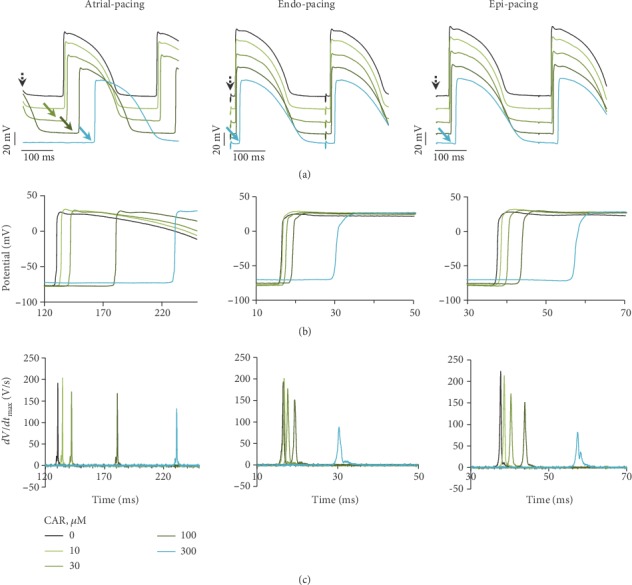
CAR effects on the APs of the Langendorff-perfused rabbit hearts. (a) Representative traces of APs from microelectrodes obtained with atrial, endocardial, and epicardial pacing under control conditions (i.e., Tyrode solution; black) and at 10, 30, 100, and 300 μM cumulatively increased concentrations of CAR (light green, green, dark green and light blue, respectively). Insert: CAR concentrations as indicated in μM. The broken black arrow indicates the start of the stimulus. Solid arrows denote the rightward shift in the AP activation time. (b) Superimposition of AP upstrokes from the same data as in (a). Note change in AP activation times vs. CAR concentrations as indicated. (c) Traces of dV/dtmax (in V/s) obtained at increased concentrations of CAR. AP upstroke velocity values were obtained from the same AP data as in (a). Note the marked decrease in conduction at 300 μM CAR (light blue).